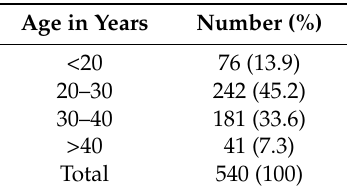
Table 1. Age distribution of pregnant